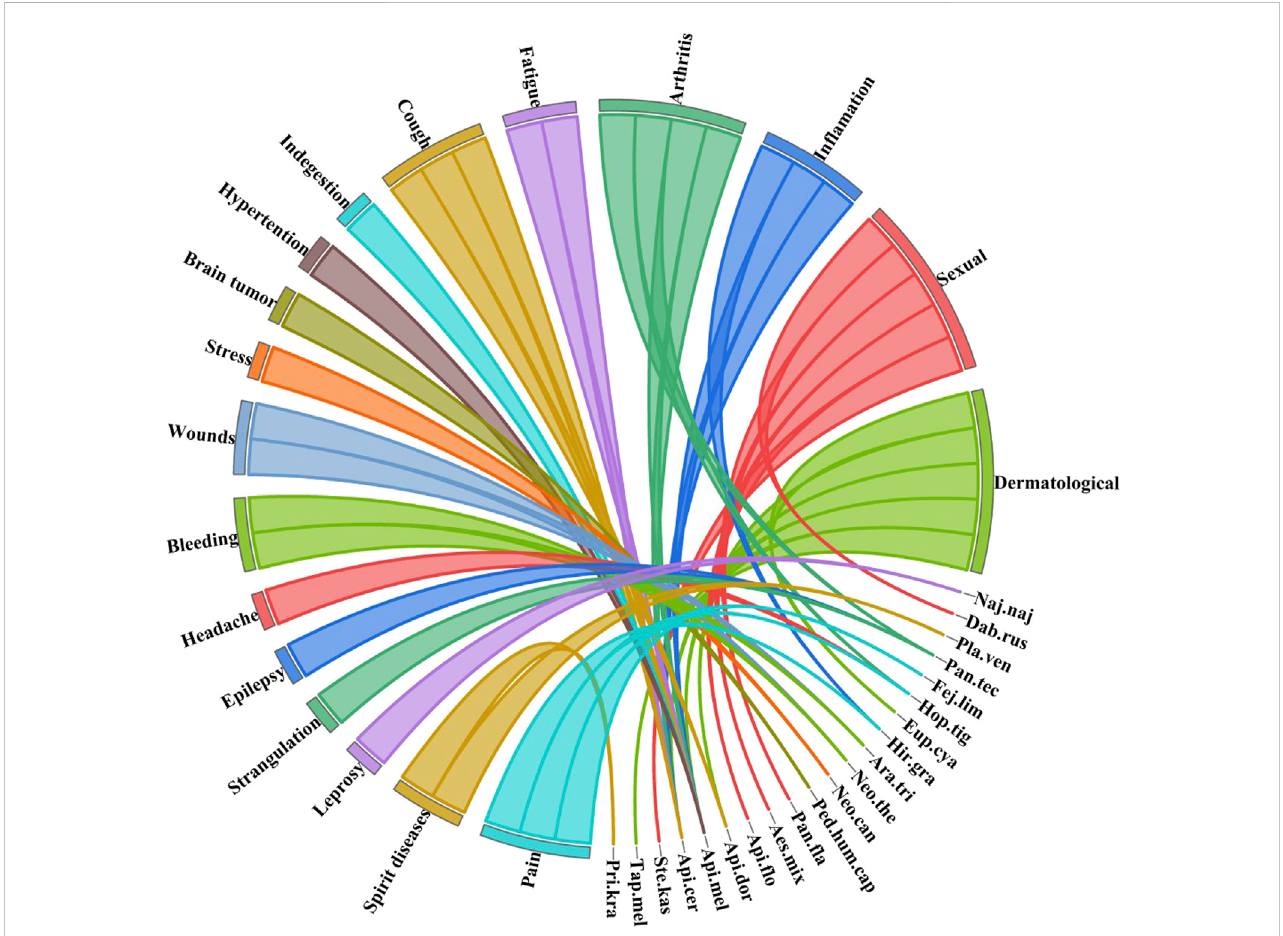
FIGURE 3 Numberofdiseasestreatedbydocumentedspecies.Thedirectionofthelinesshowsspeciesassociationwiththeparticulardisease,andthethicknessof each bar shows the number of species used to treat that particular disease. The complete name of each species is shown in Table